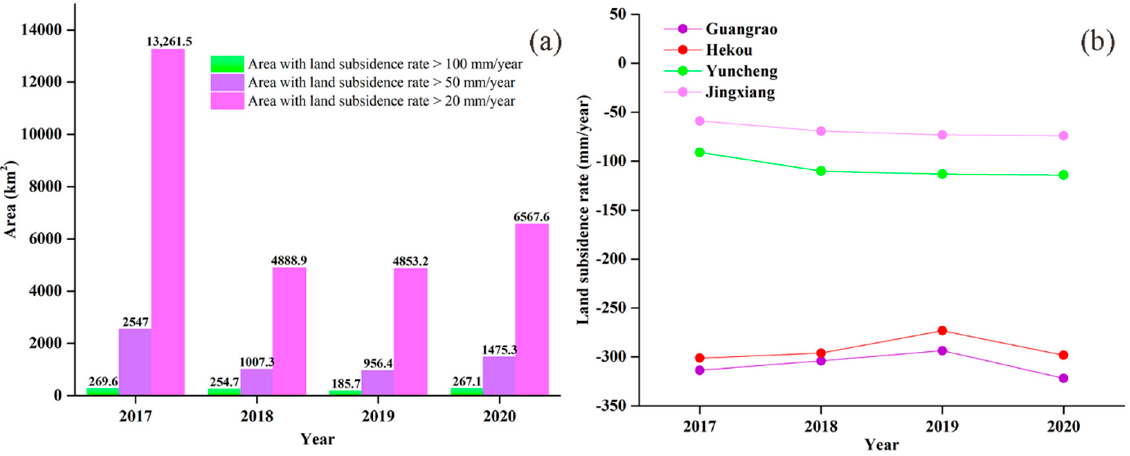
Figure 5. ( a ) Changes in the area with land subsidence rate exceeding 100, 50, or 20 mm/year in SDP. ( b ) Changes in the land subsidence rates of four subsidence features.